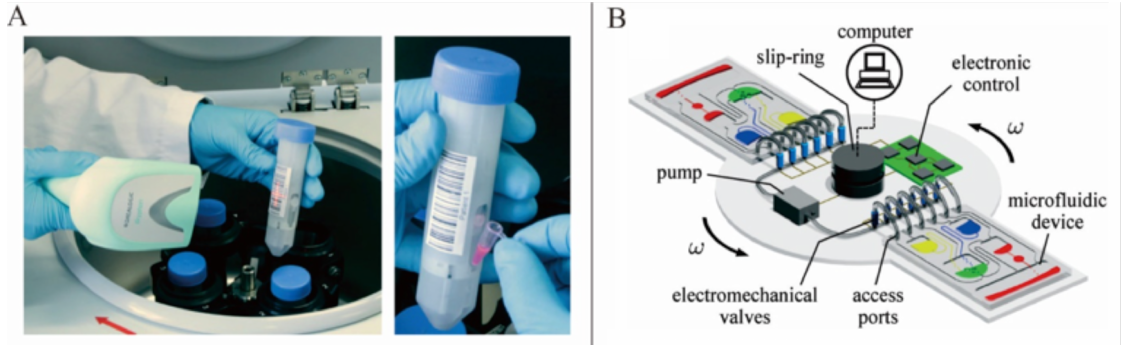
Figure 12. ( A ) LabTube system for centrifugal microfluidics. Figure reprinted with permission from [152]. ( B ) Active pneumatic control of centrifugal microfluidic flows. Figure reprinted with permission from [156].